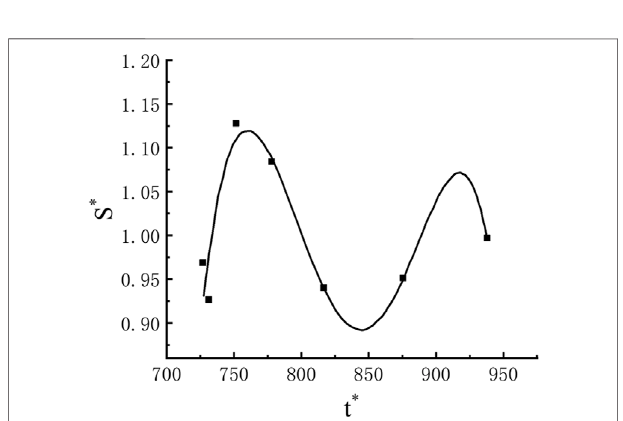
FIGURE 12 | Changes of vortex intensity coef fi cients at different formation times.